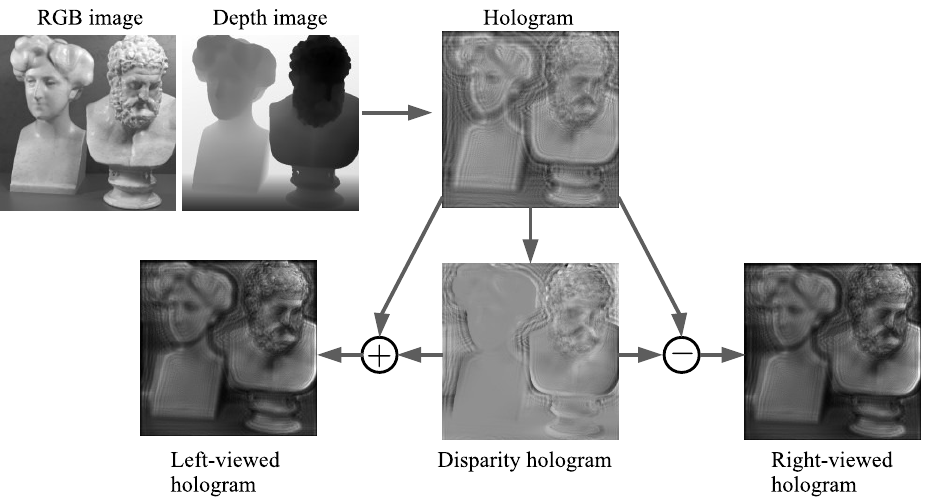
Figure 1. Outline of the proposed method. It yields left- or right- viewed holograms by adding or subtracting a disparity hologram, respectively. We used the 3D model provided from